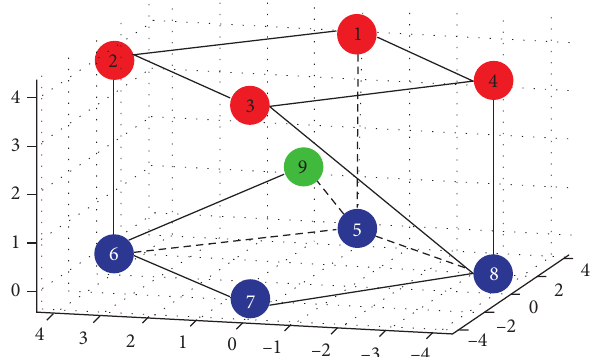
Figure 4: A perfectly controllable